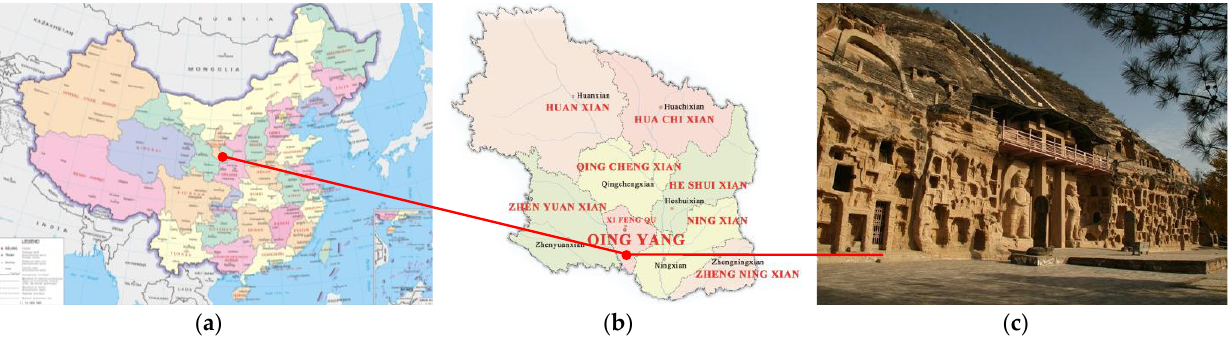
Figure 2. Rock sampling site: Qingyang, Gansu, China. ( a ) Map of China; ( b ) map of Qingyang; ( c ) north Grottoes.